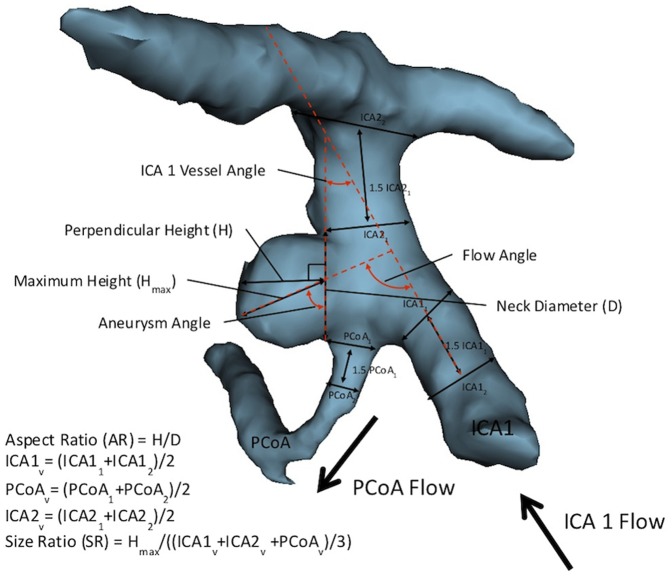
3D model of PCoA aneurysm depicting morphological variables previously studied in the literature.The aspect ratio (AR) is obtained by dividing the perpendicular height by the neck diameter. Size ratio (SR) is calculated by dividing the maximum height (Hmax) by the average composite diameter of the all vessels (ICA1v, PCoAv, ICA2v) involved with the aneurysm. Composite diameters are obtained by averaging the initial diameter of the vessel (ICA11, PCoA1, ICA21) at the aneurysm neck or branching point with the diameter of the vessel 1.5 away from the initial diameter (ICA12, PCoA2, ICA22). Aneurysm angle is defined as the angle between the vector formed by the maximum height of the aneurysm with the aneurysm neck. The vessel angle is defined as the angle between the vector of flow and the neck of the aneurysm. The flow angle is defined as the angle between the vector of flow and the vector formed by the maximum height of the aneurysm.